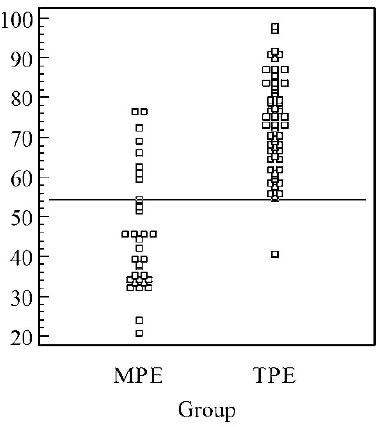
Figure 1 - Comparison of pleural effusion SOD2 concentrations between patients with TPE (n=54) and those with MPE (n=33). The horizontal bar indicates the cut-off point (54.2 ng/mL).